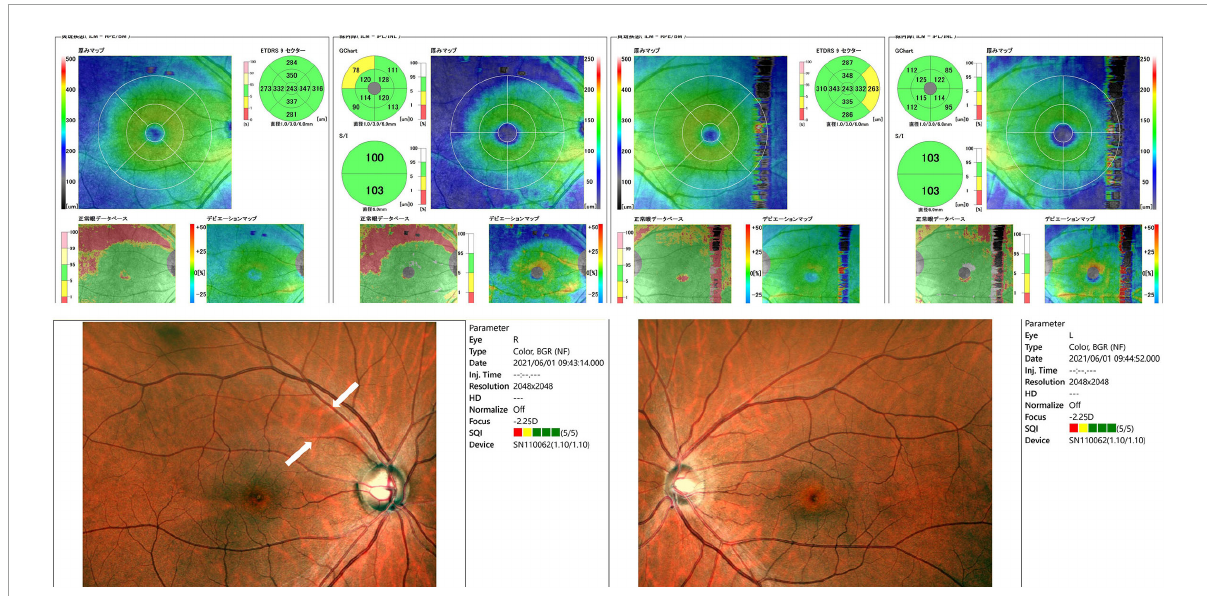
FIGURE1 Retinal photographs and thickness evaluation of the macular ganglion cell complex using optical coherence tomography. Retinal nerve fiber layer defects (white arrows, bottom left image) were observed in the right eye. Optical coherence tomography also showed thinning of the macular ganglion cell complex in the temporal superior aspect.